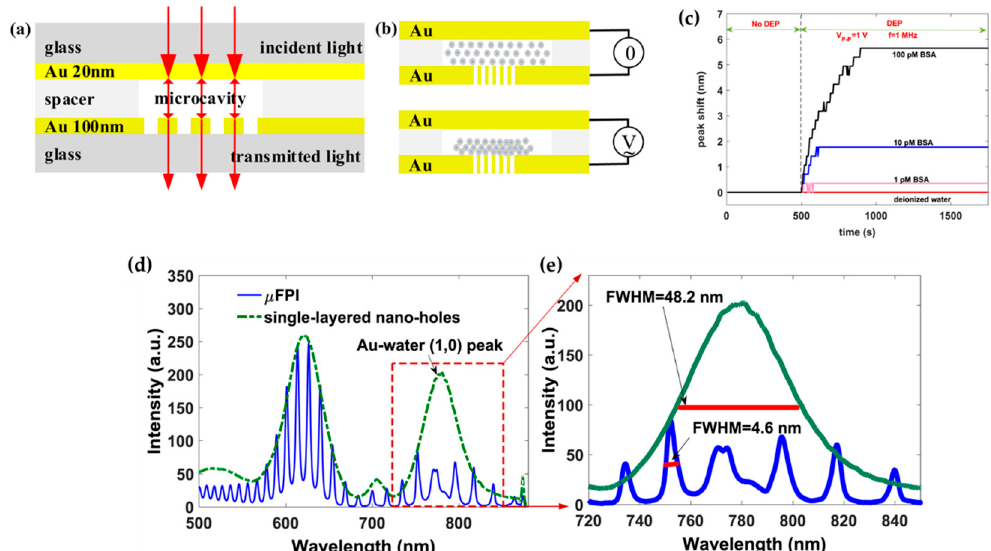
Figure 11. ( a ) Schematic representation of the plasmonic sensing device. ( b ) Conceptual representation of DEP on particle transportation. ( c ) DEP effect on transporting BSA proteins in different concentration solutions. ( d ) Transmission spectrum for the nanohole array with two peaks from the EOT effect (green dash-dot curve) and FP resonances within the transmission profile (blue solid curve). ( e ) Zoomed in curve for the transmission peak in the long wavelength range. Adapted from [143], with permission © 2018 Elsevier B.V.